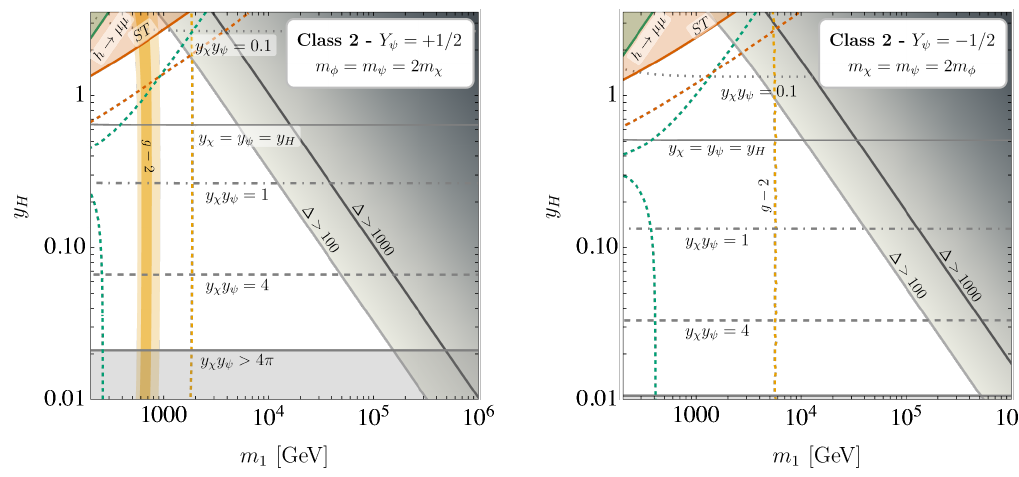
Figure 5 . Theoretical (grey) and experimental (coloured) constraints on the Class 2 benchmark model (see figure 3 for details). The product of Yukawas required to reproduce the observed muon mass is shown by contours at y χ y ψ ∈ { 0 . 1 , 1 , 4 , 4 π } and we also show a contour where y χ = y ψ = y H . The left plot shows that the ( g − 2) model for m ≈ 600 GeV, almost independently of y 1 scale there is a slight dependence on y If the anomaly disappears, future measurements of ( g − 2)